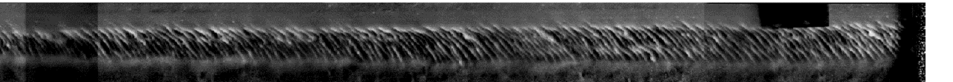
Figure 8. Phase image with fading in (0–100%) of pixel values on the left and fading out (100–0%) of pixel values on the right side.